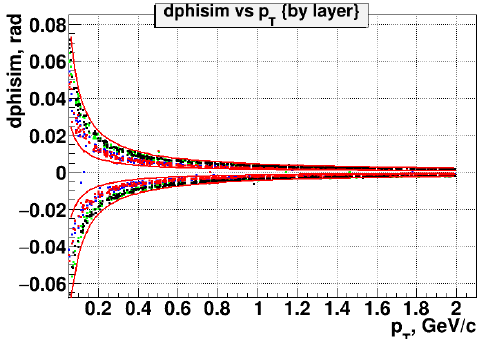
Figure 6. Transverse angle di ff erence for di ff erent layers as a function of p T along with the chosen angular cuts (red lines). Positive and negative values correspond to oppositely charged particles. Blue and red bands correspond to the transverse angle di ff erences for layers 1 and 2, green and black ones to layers 3 and